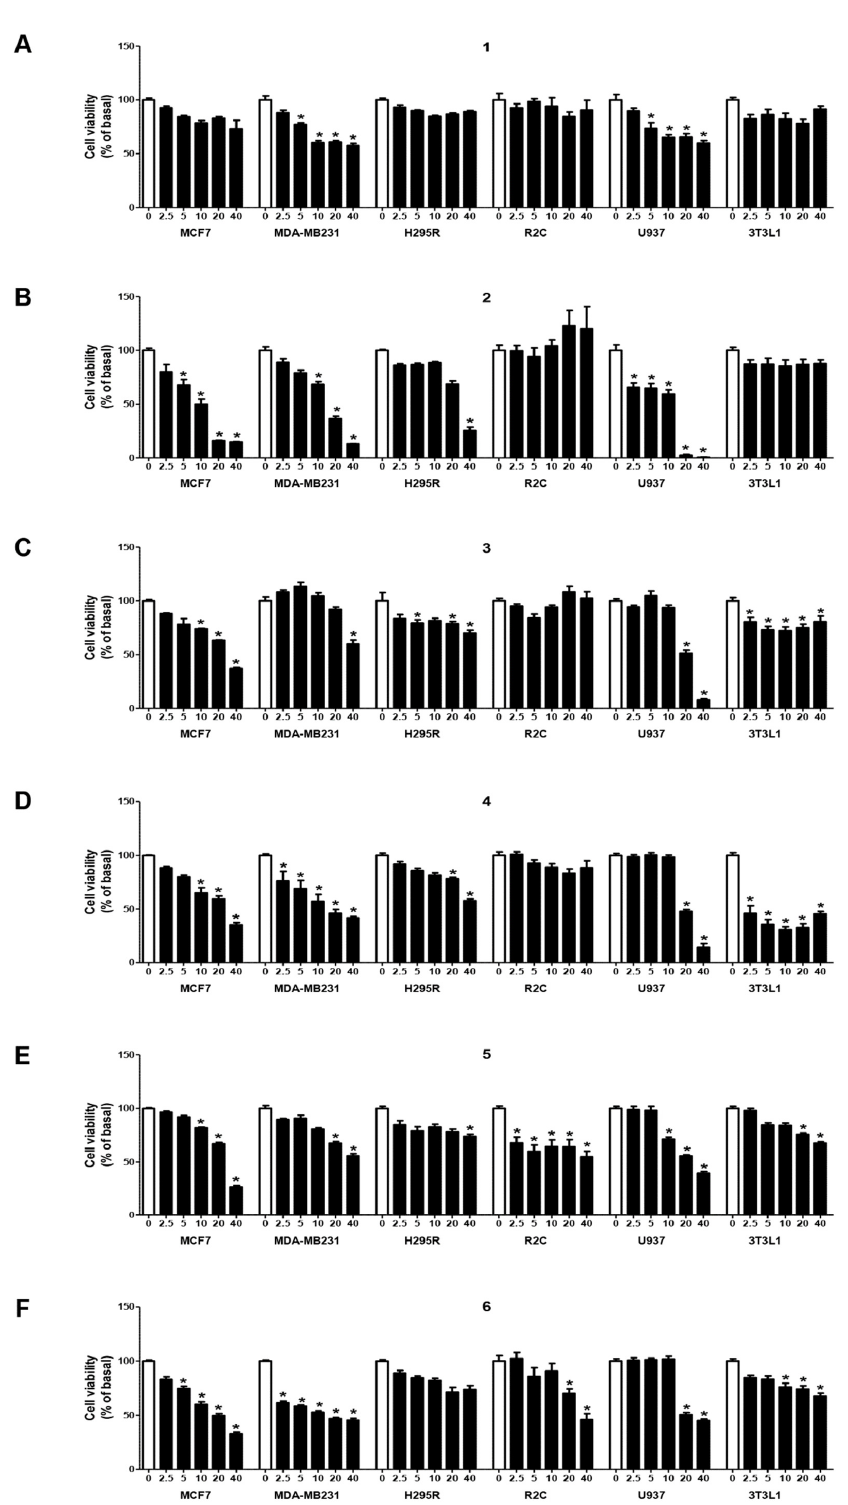
Figure 2. Effects of phenylacetamide RSV derivatives on cancer cell viability. MCF7, MDA-MB231, H295R, R2C, U937, and 3T3L1 cells were treated with vehicle DMSO (0) or the following pheny- lacetamide RSV derivatives: 1 ( A ), 2 ( B ), 3 ( C ), 4 ( D ), 5 ( E ), or 6 ( F ) at the indicated concentrations (2.5, 5, 10, 20, and 40 µ M). Cell viability was assessed by MTT assay after 72 h exposure. Results are expressed as mean ± SE of three separate experiments (* p < 0.05 with respect to control